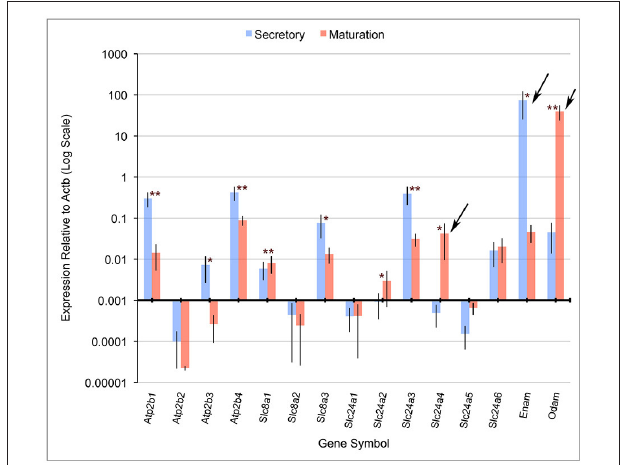
FIGURE 1 | Real-time PCR for rat Atp2b, Slc8a, and Slc24a gene family members. Atp2b1, Atp2b3, Atp2b4, Slc8a3, and Slc24a3 have significantly higher expression in secretory stage than maturation stage, while Slc8a1, Slc24a2, and Slc24a4 were significantly more highly expressed in maturation stage compared to secretory stage. β -actin (Actb) served as a normalizing control, and enamelin (Enam) and Odam as control transcripts that were significantly down-regulated and up-regulated, respectively (as expected), during maturation-stage amelogenesis. Slc24a4, Enam and Odam (arrows) have all been linked to non-syndromic cases or amelogenesis imperfecta. The x-axis is placed at the 0.001 expression level relative to Actb, and below this “cut-off” figure is arbitrarily considered non-significant. The Student’s t -test (paired two-tail) was used to compare the expression of each gene between the secretory and maturation stages (* p < 0.05, and ** p < 0.01). Standard deviations are also included.